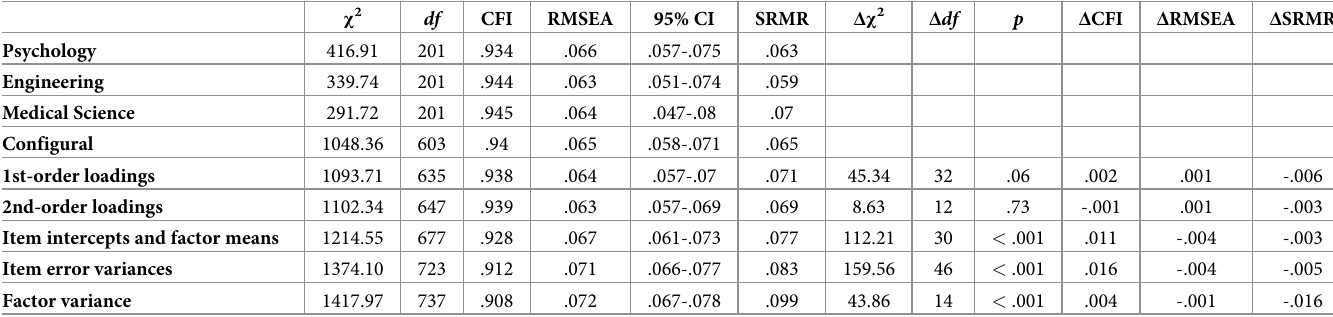
Table 4. Measurement invariance test across study domains for Model